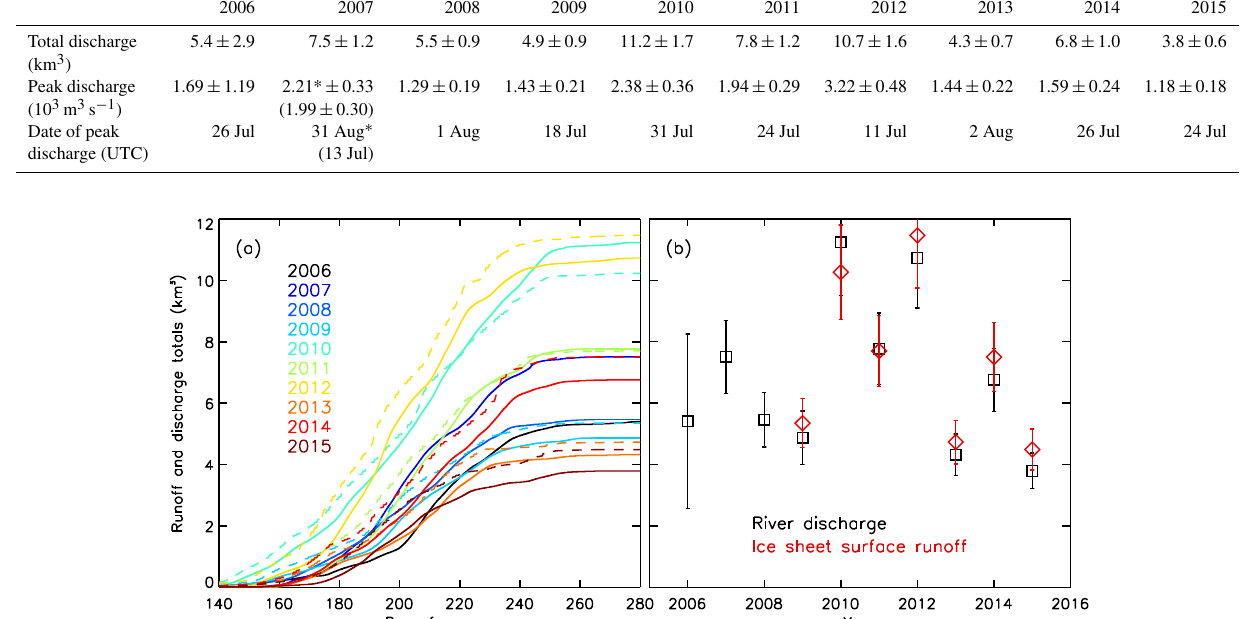
tative of the lowest elevation of the regional ice sheet margin indicates that p falls in the range 1.2–1.6 for the Kangerlus- suaq catchment. An independent method using the elevations of six on-ice weather stations and their distance to the margin gives p = 1.3 ± 0.2, ignoring changes in catchment width with elevation. Plotting Fig. 4 with logarithmic axes confirms the relation between river discharge and air temperature with exponent p =